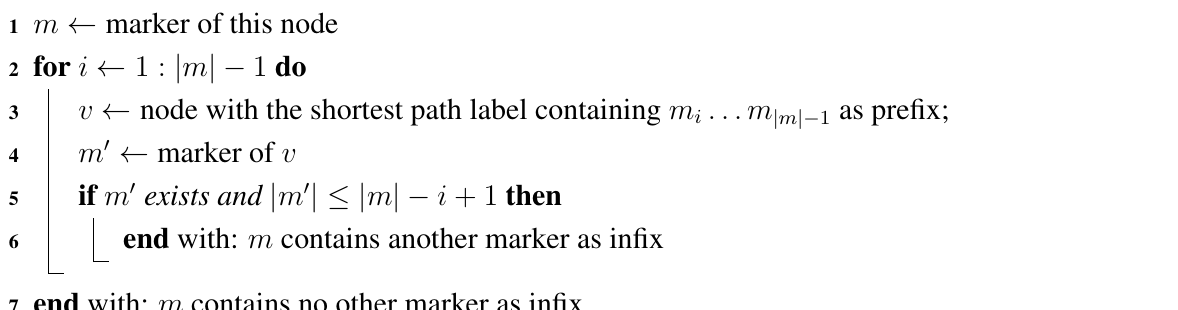
Algorithm 2: Suffix Search applied on a node. For a node v with path label w = w (cid:48) w (cid:48)(cid:48) and parent node v (cid:48) with path label w (cid:48) the marker of a node is defined as m = w (cid:48) u where u is the first character of w (cid:48)(cid:48) (in case of the annotation guided suffix tree) or as m = w (cid:48) a where a is the shortest prefix of w (cid:48)(cid:48) such that m is significant (in case of the probability based suffix tree). If w does not suffice